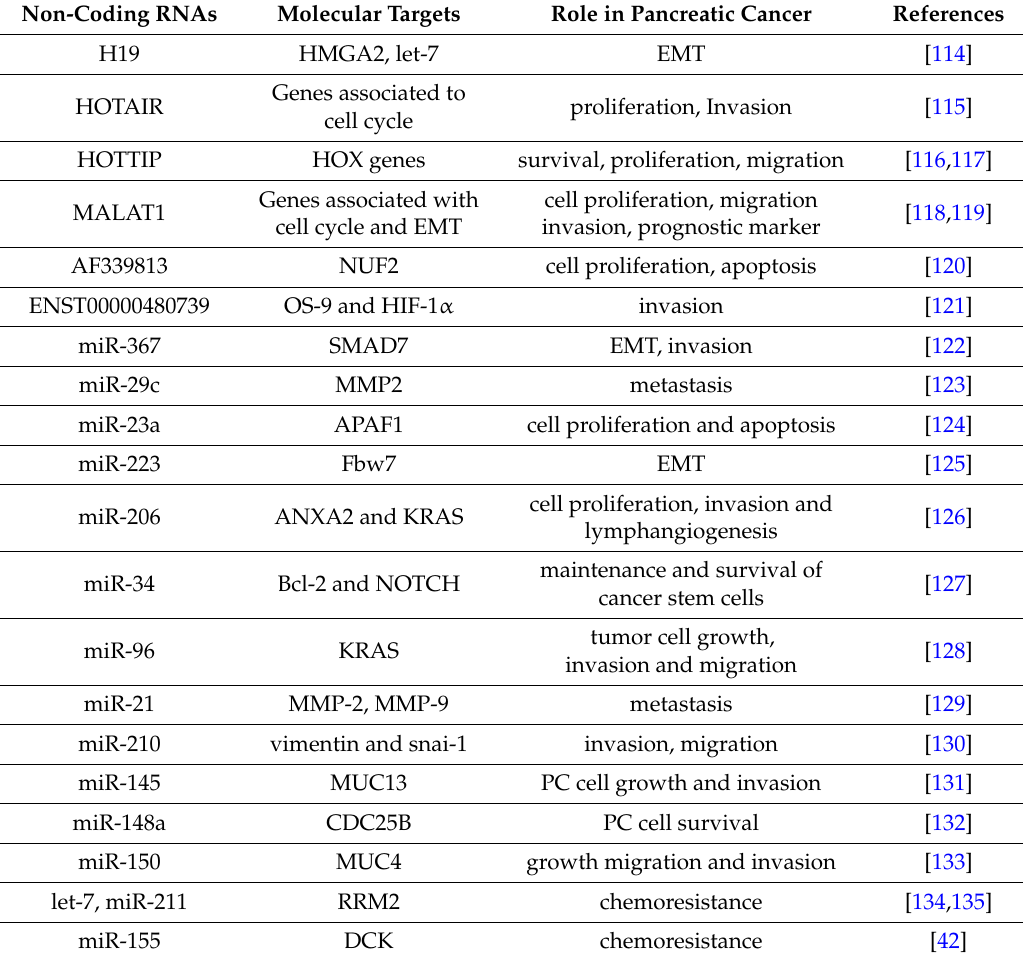
Table 1. Non-coding RNAs in pancreatic cancer